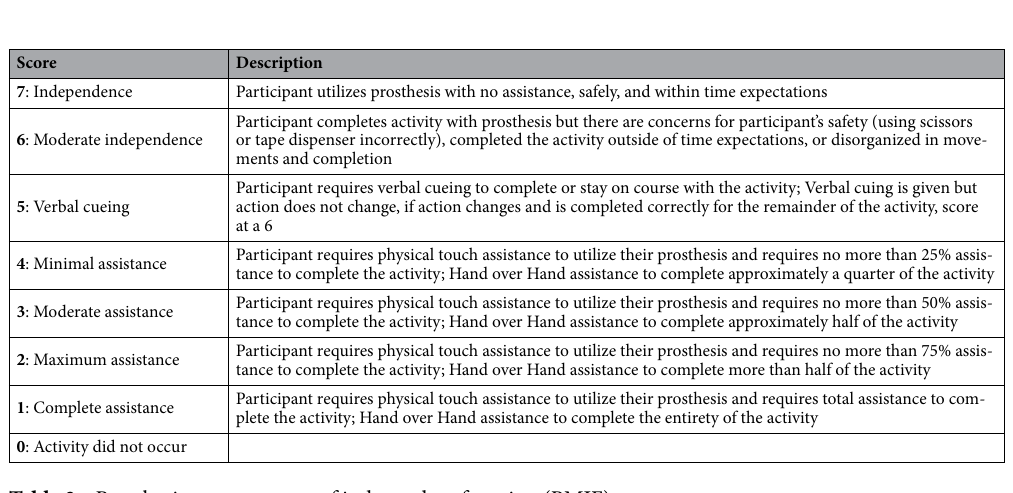
Table 2. Prosthesis measurement of independent function